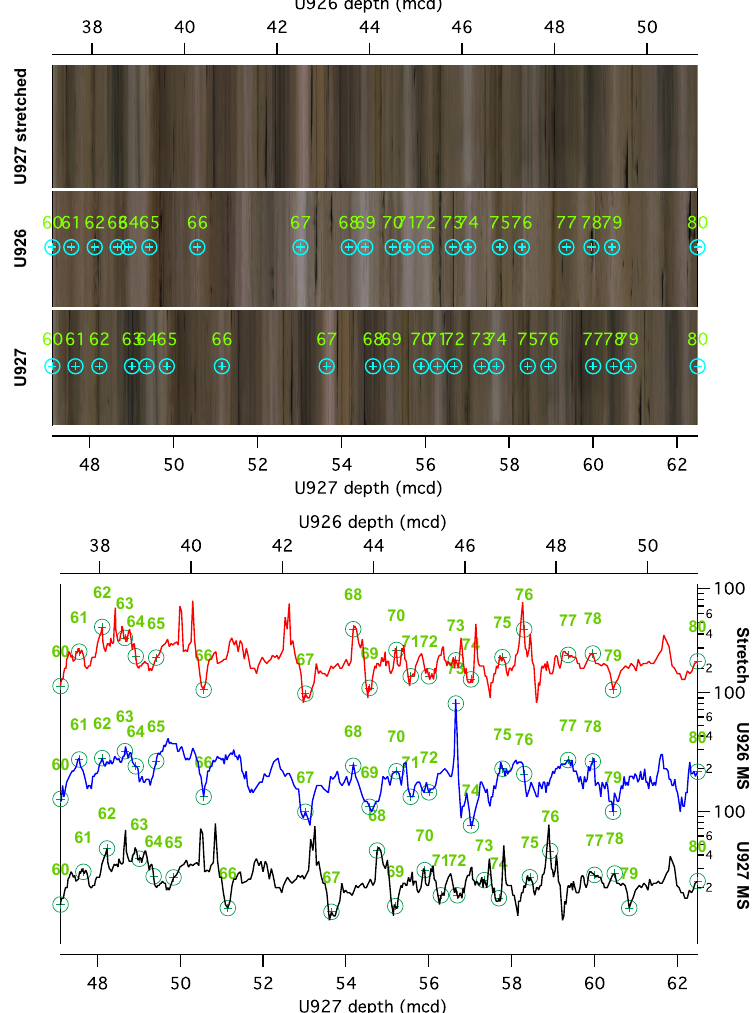
Figure 5. Spliced images and MS data from ODP sites 926 and 927. There have been small adjustments to the published splices for each site. Site 927 data and image are plotted versus the Site 927 depth scale on the bottom of each graph and versus the Site 926 depth scale at the top. Green numbers indicate tie points between the sites used to stretch the Site 927 image and